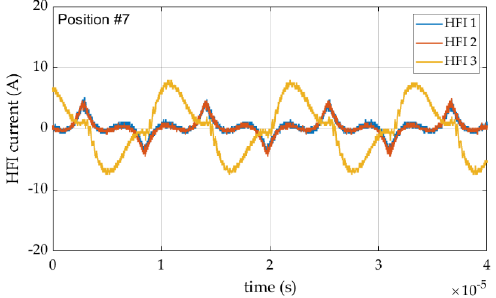
Figure 22. HFIs output currents with full coupling with the third track coil (Position #6).